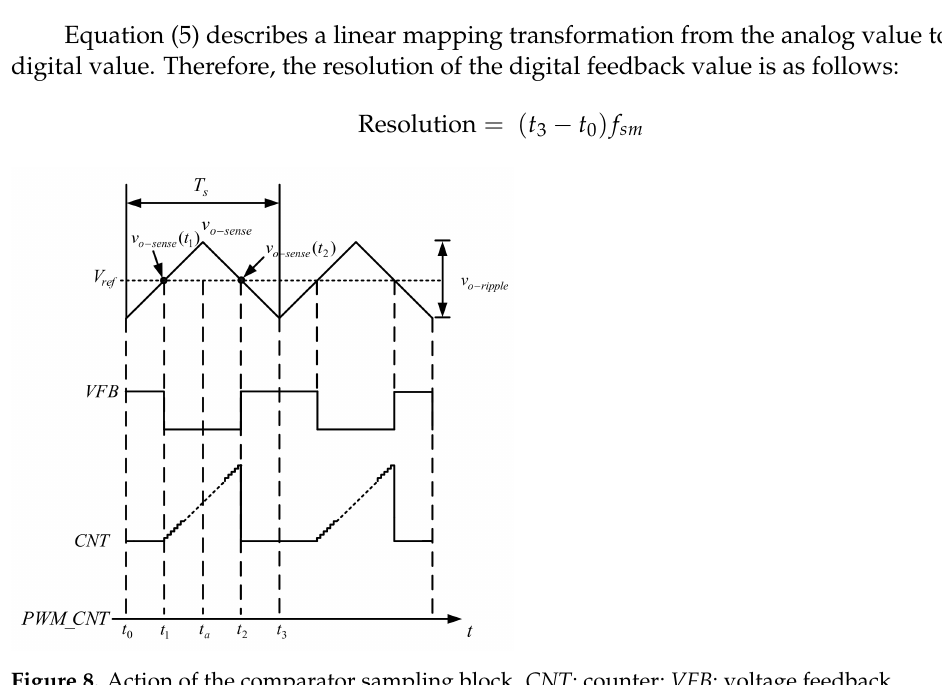
Figure 8. Action of the comparator sampling block. CNT : counter; VFB : voltage